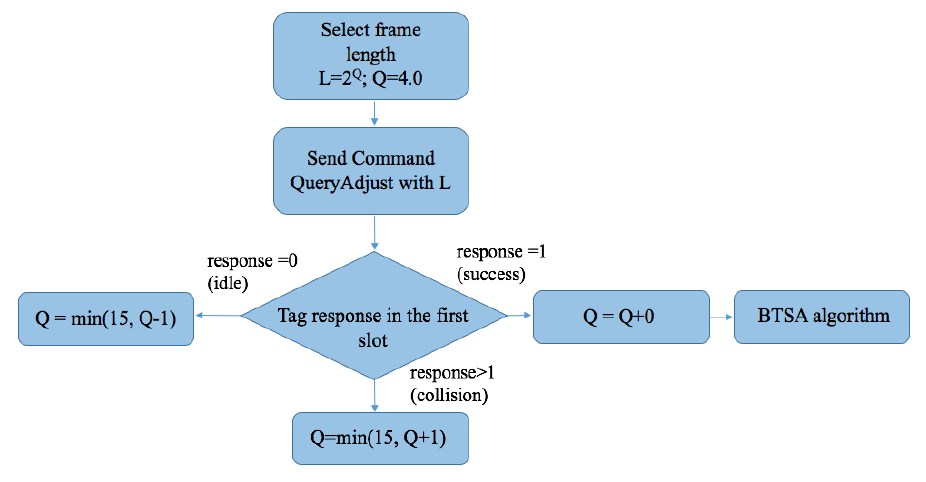
Figure 23. Flow chart of Dynamic